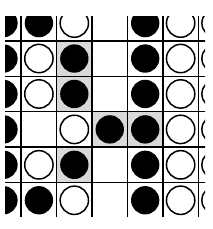
Figure 35. WHITE wins.